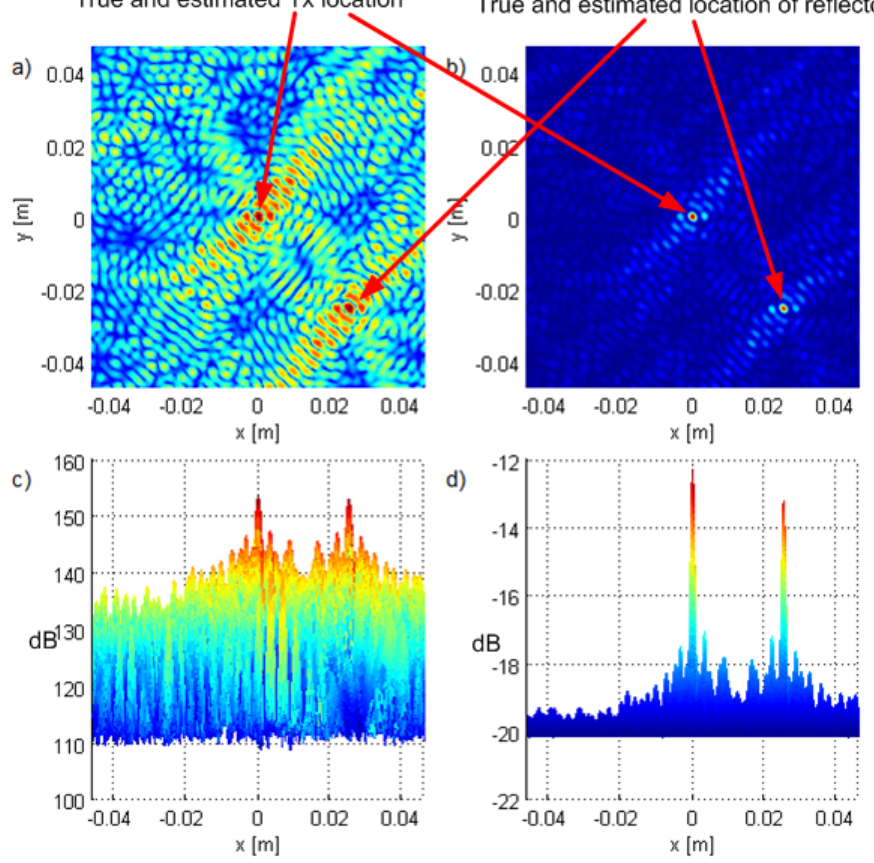
Figure 16. One user with an ideal reflector scenario: top views of the criterion functions for G 90 and T 1 for ( a ) ML-US, ( b ) SCM-MUSIC, and the corresponding side views in ( c , d ) with the magnitude in